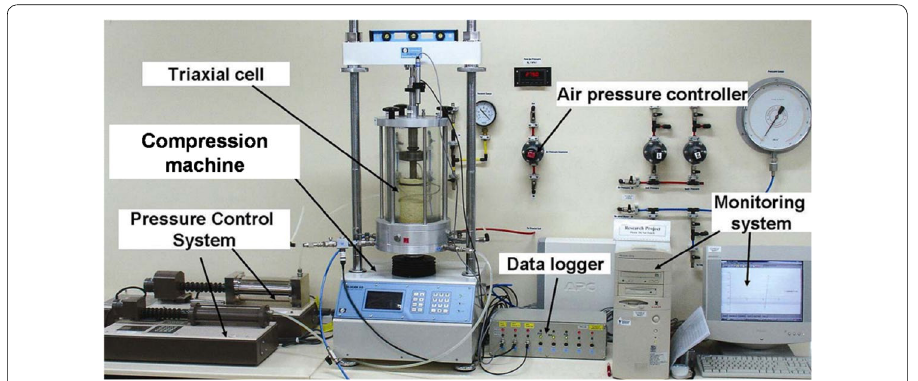
Fig. 7 Configuration of unsaturated triaxial